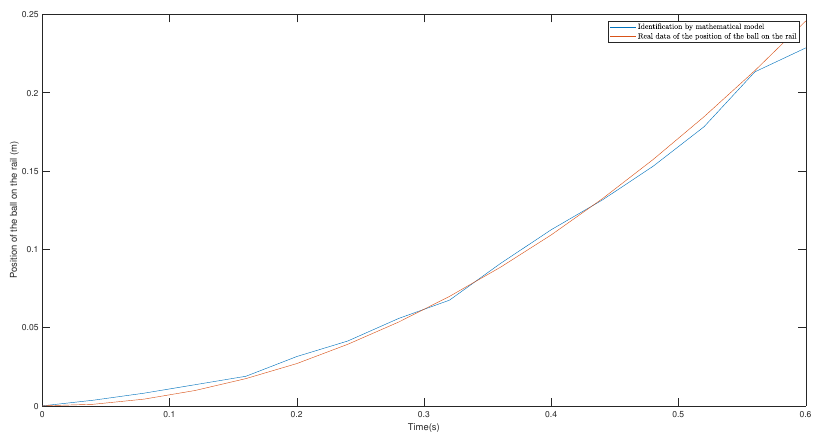
Figure 13. Mathematical model of the dynamics of the fall of the ball in comparison with the natural dynamics of the fall.